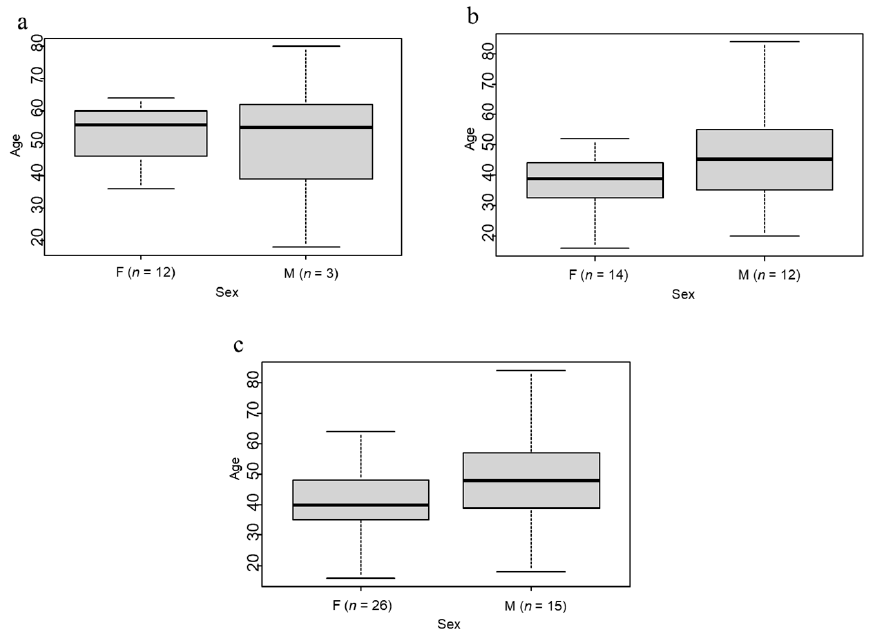
Figure 1. Boxplots of sex and age in the subsamples of suicide ( a ) and homicide ( b ) and the complete sample ( c ).